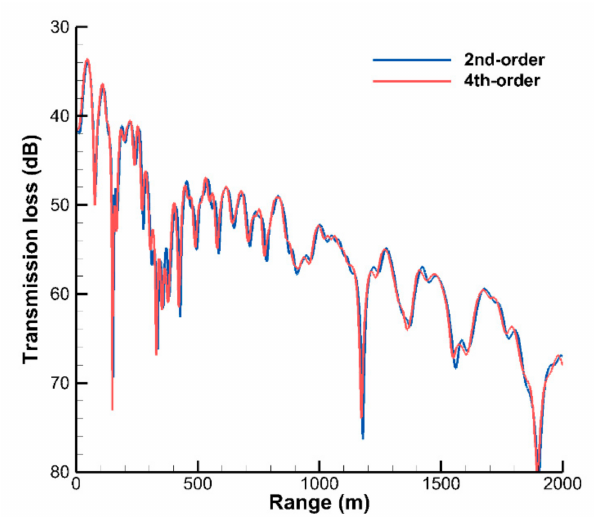
Figure 8. TL curves along z = 90 m for the Bucker waveguide.